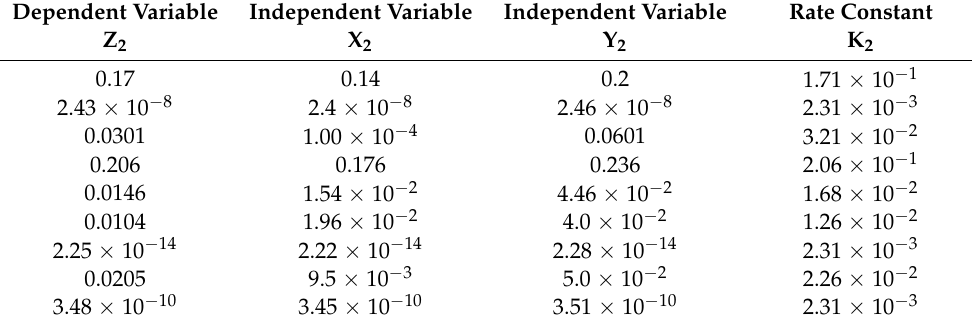
Figure 6. Data trending plot between dependent variable Z 3 and predictor variables X 3 and Y 3 with a difference of 0.04 from the experimentally fixed value at 420 ◦ C. Table 5. Multiple linear regression model with a difference of 0.03 from the experimental fixed values at 420 ◦ C. Where ‘***’ shows a statistically significant